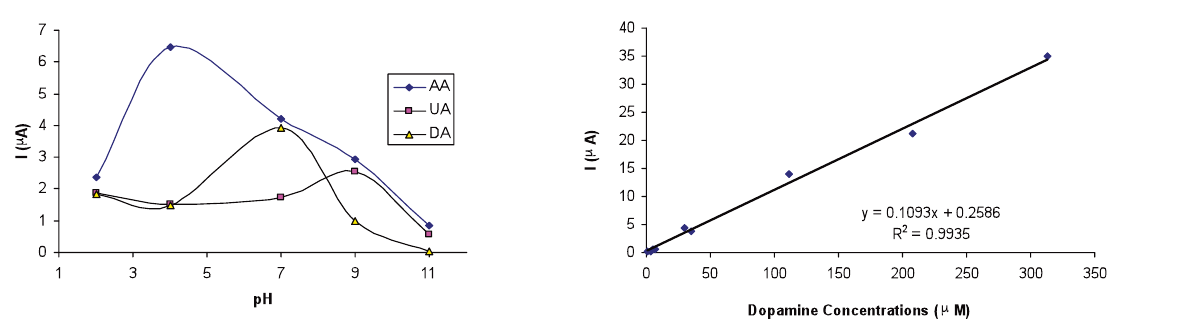
Figure 1. Effect of pH on peak currents of AA, UA and DA. Figure 3. Dopamine individual calibration.